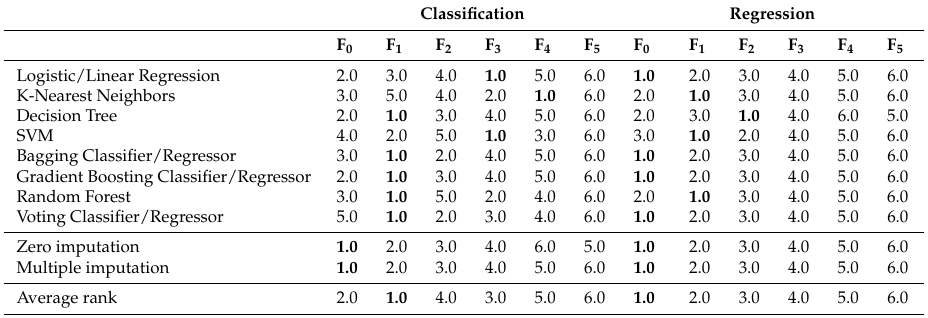
Table 9. Rankings of feature sets for different classification and regression models for fiber.